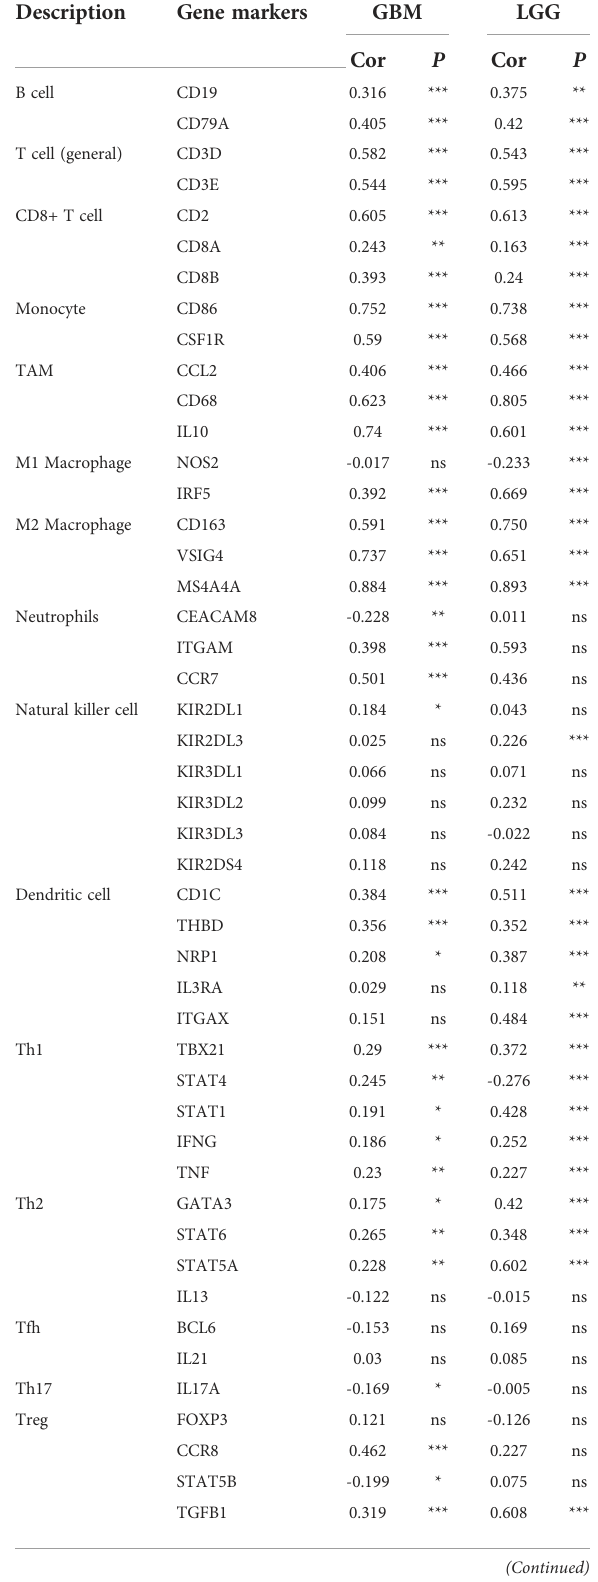
TABLE 2 Correlation analysis between MS4A6A expression and related markers of immune cells using data in TIMER database.